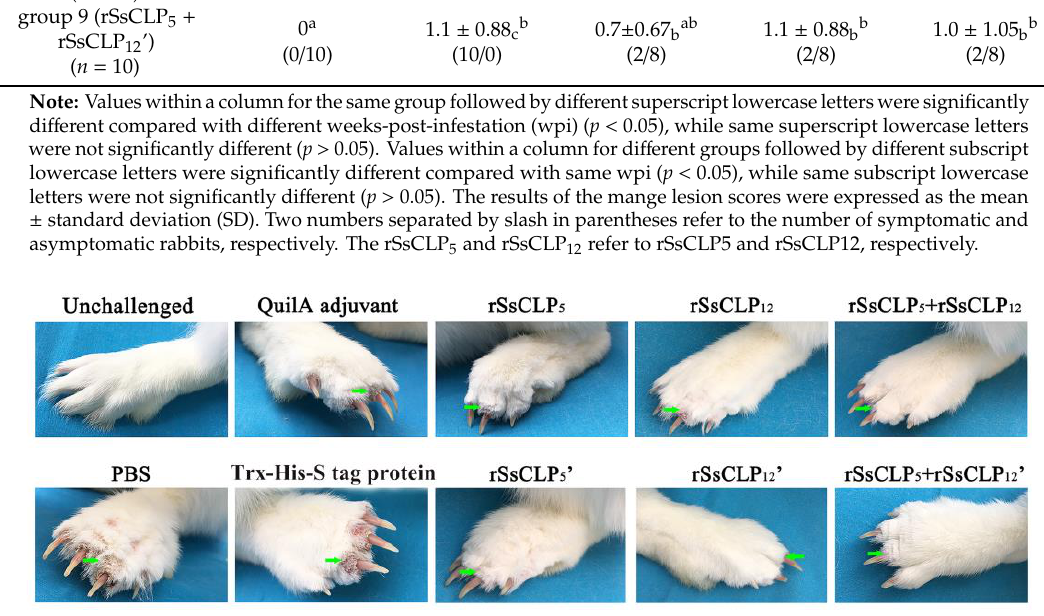
saponin at a concentration of 1 mg / mL (dissolved in PBS) each time; Trx-His-S tag protein, vaccinated